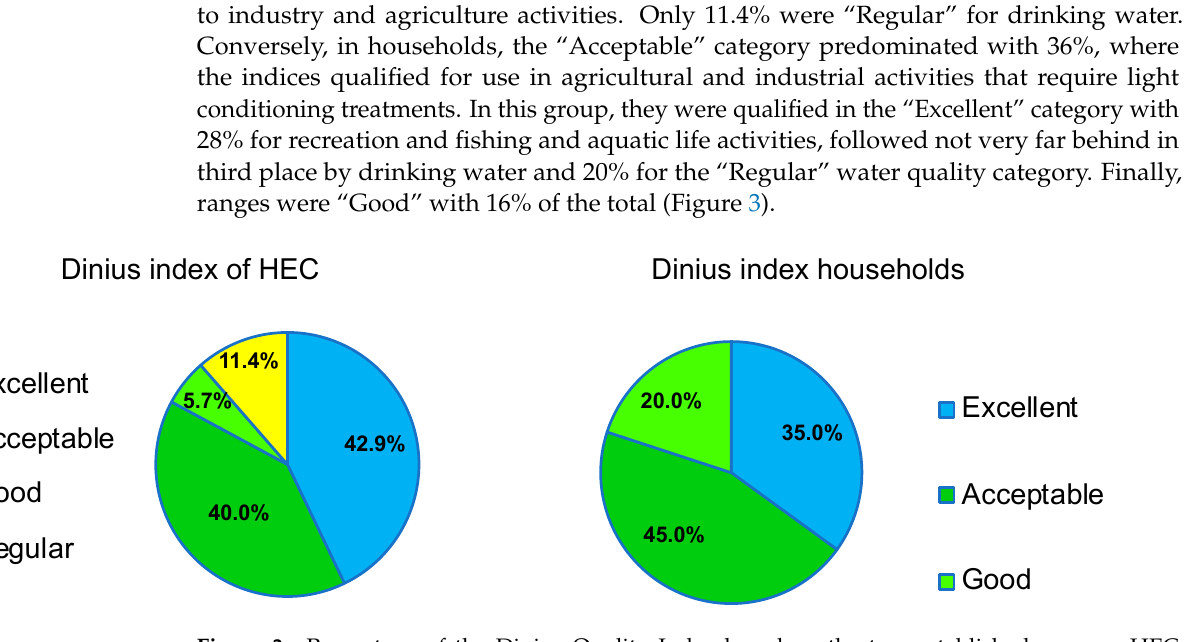
Figure 3. Percentage of the Dinius Quality Index based on the two established groups: HEC and households.